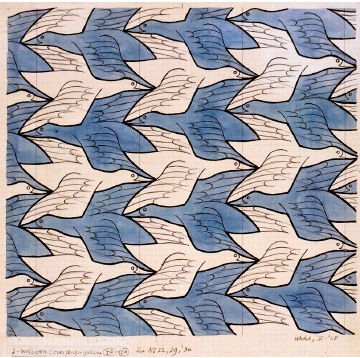
Figure 9. M. C. Escher, Transitional system I-I ,